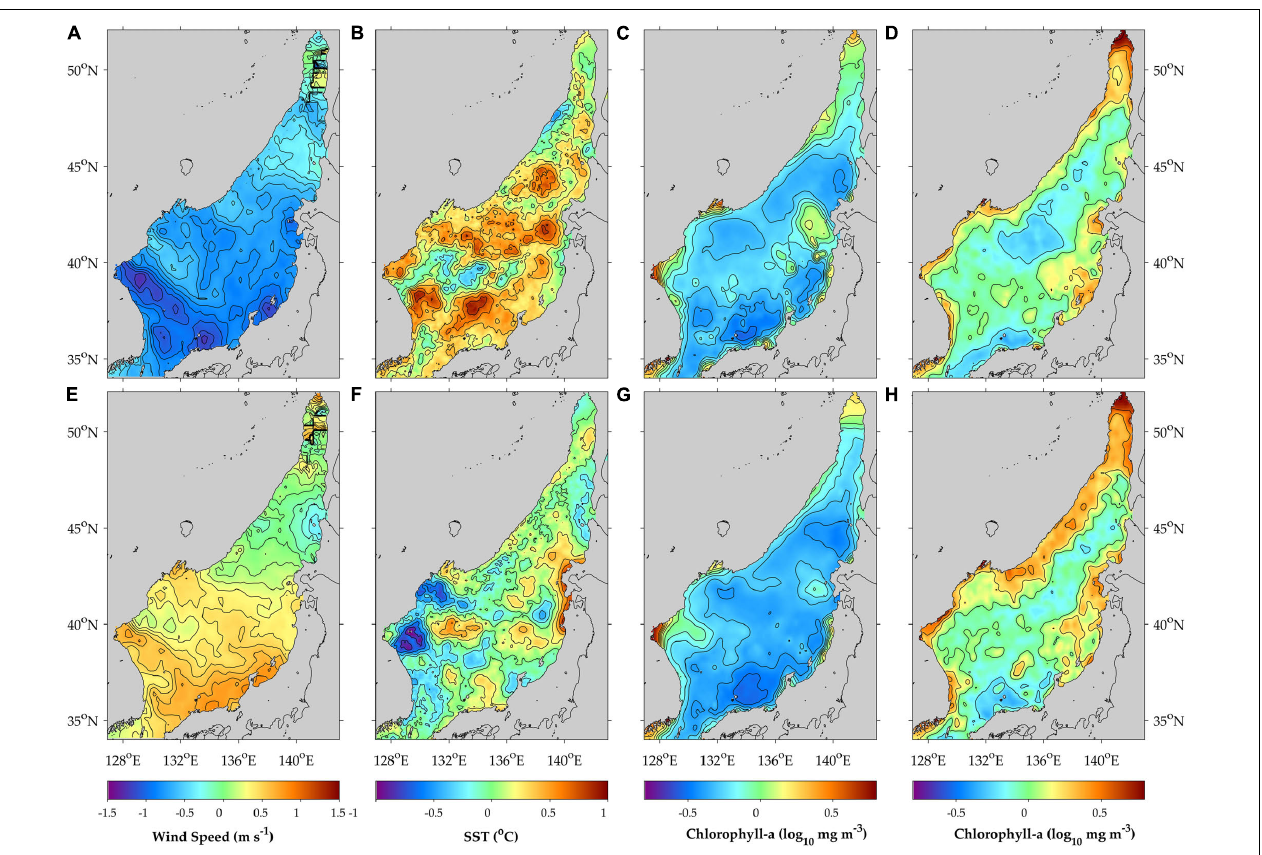
FIGURE 10 | Spatial distributions of the (A) mean wind speed anomaly, (B) sea surface temperature (SST) anomaly, and (C) chlorophyll- a concentration (Chl a ) anomaly averaged over the periods of the positive AO index ( > 1) in winter (December, January, and February) and (D) Chl- a anomaly in spring (March–May). (E–H) Are the same as (A–D) for the negative phase of AO ( <